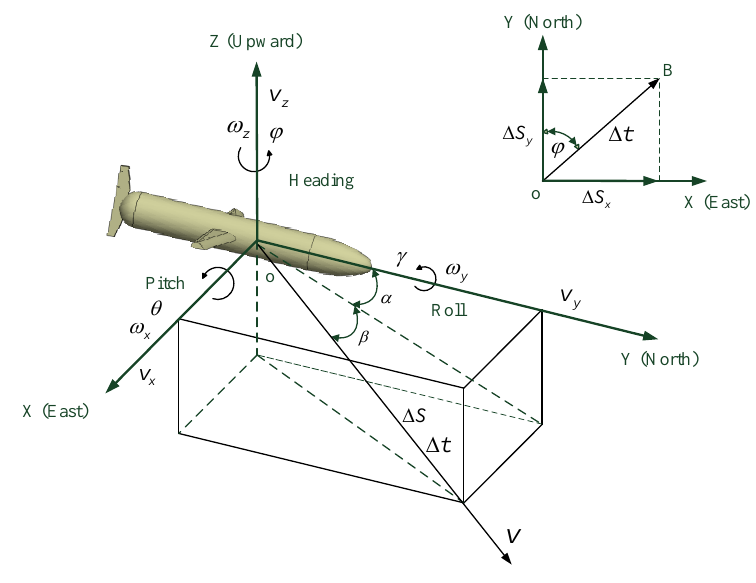
Figure 1. The underwater glider